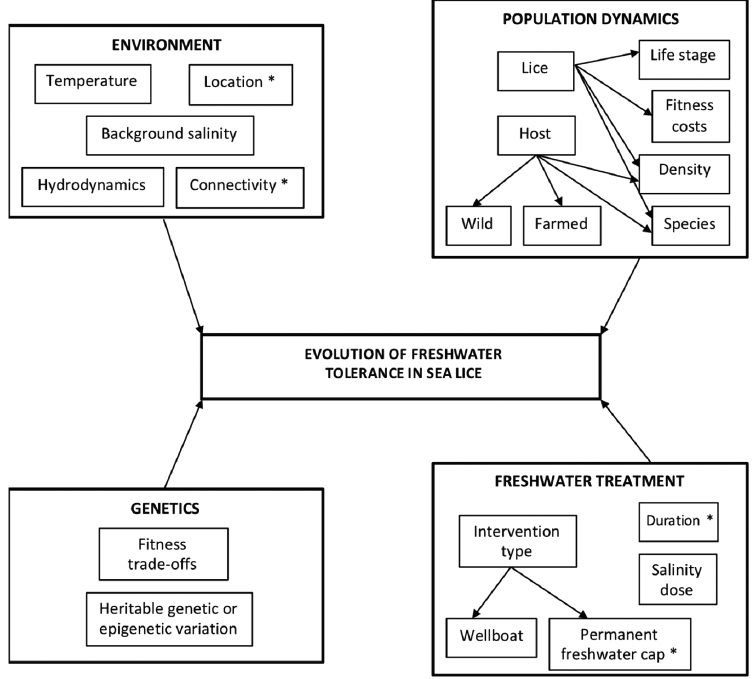
Fig. 2. Key factors identified from the recent literature review (Groner et al. 2019) that may affect the risk of sea lice evolving tolerance to freshwater treat- ments. Asterisks indicate factors with further explanatory notes as follows: location (environmental salinity, exposure to freshwater run-off, sensitivity of associated lice population to freshwater, etc.); connectivity (farm to farm, wild to farm, farm to wild, direction of water current, density of wild versus farmed hosts, etc.); duration (length of exposure, number of repeated exposures); and permanent freshwater cap (snorkel cages,